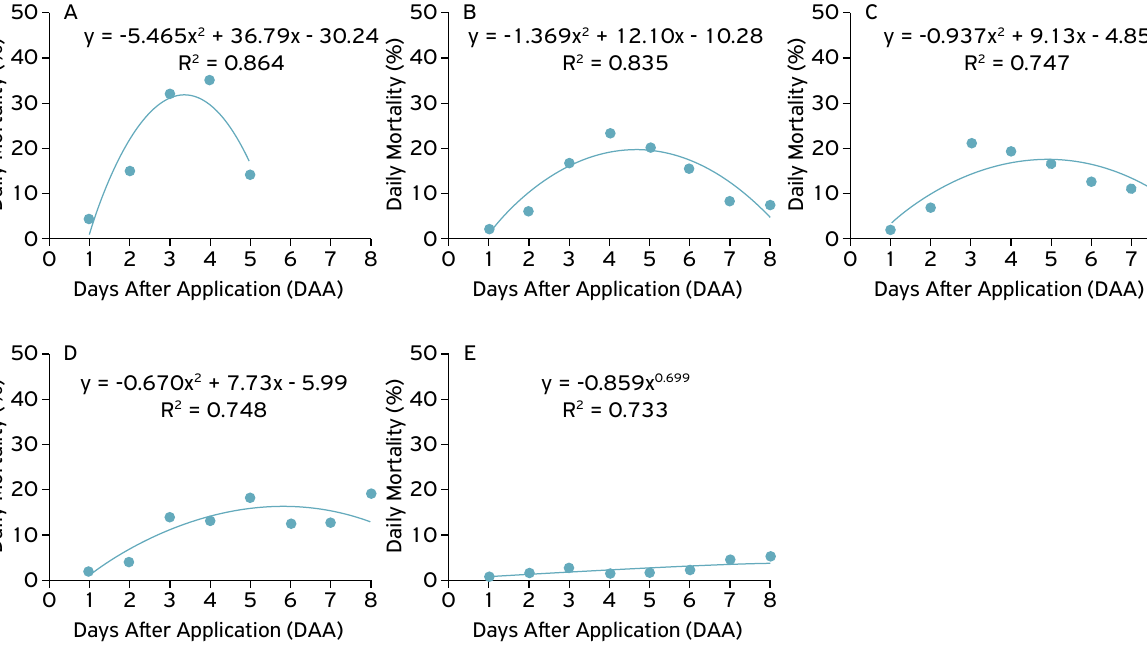
Figure 2. Daily mortality of D. melacanthus after application of different isolates of the M. anisopliae in the laboratory. (A) 08RA isolate; (B) 05RA isolate; (C) 11RA isolate, (D) 02RA isolate; (E)